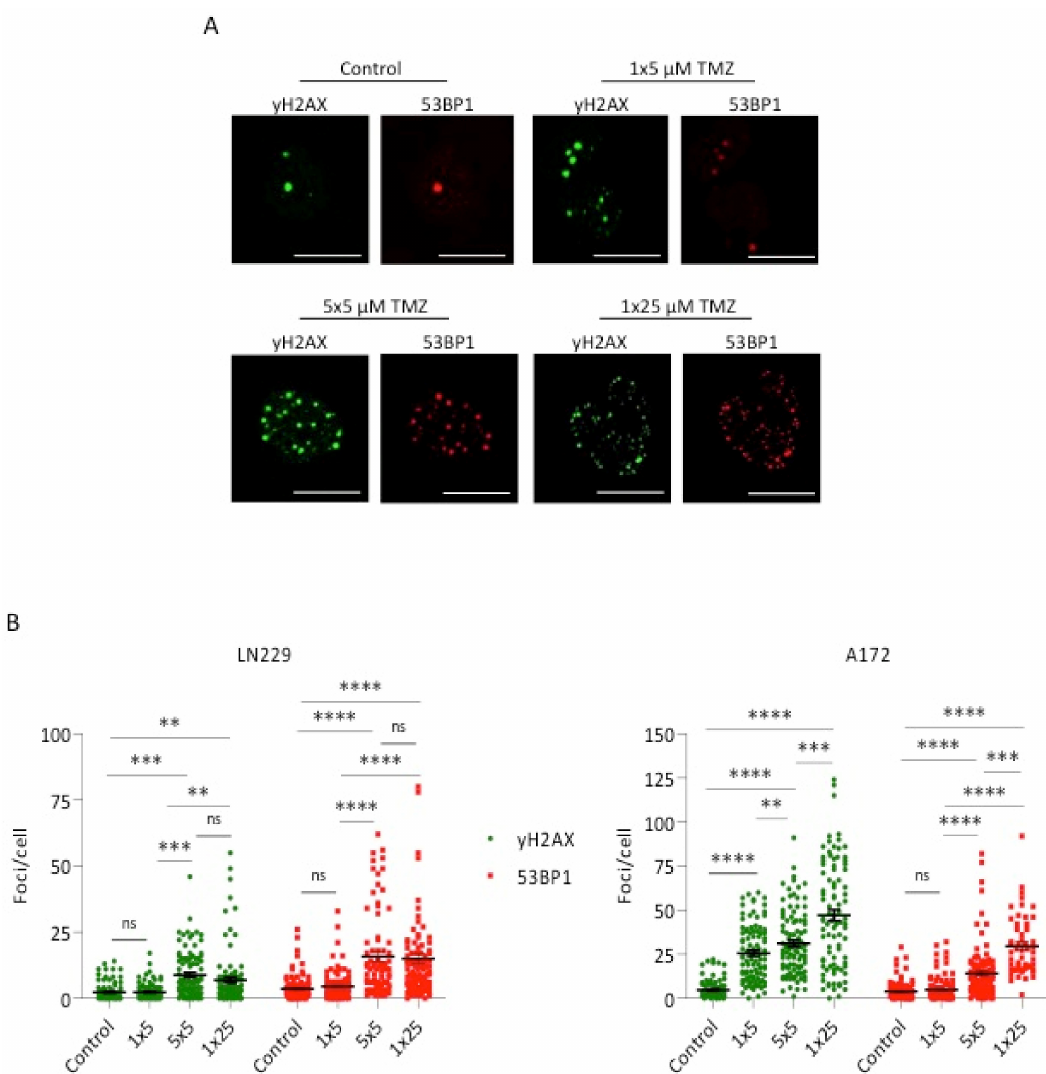
Figure 3. Induction of DSBs, measured by γ H2AX and 53BP1 staining and foci quantification through LSM, in LN229 and A172 following a single dose of 5 or 25 µ M or 5 repeated doses, each of 5 µ M TMZ. ( A ) Representative images for γ H2AX and 53BP1 foci staining in LN229 cells for the indicated treatments. Scale bars indicate 30 µ m. ( B ) Foci number per cell in the controls and upon treatment. Data of a representative experiment are shown, with 100 cells counted for each treatment. Bars indicate the mean. n.s. = not significant; ** p < 0.01; *** p < 0.001; **** p <